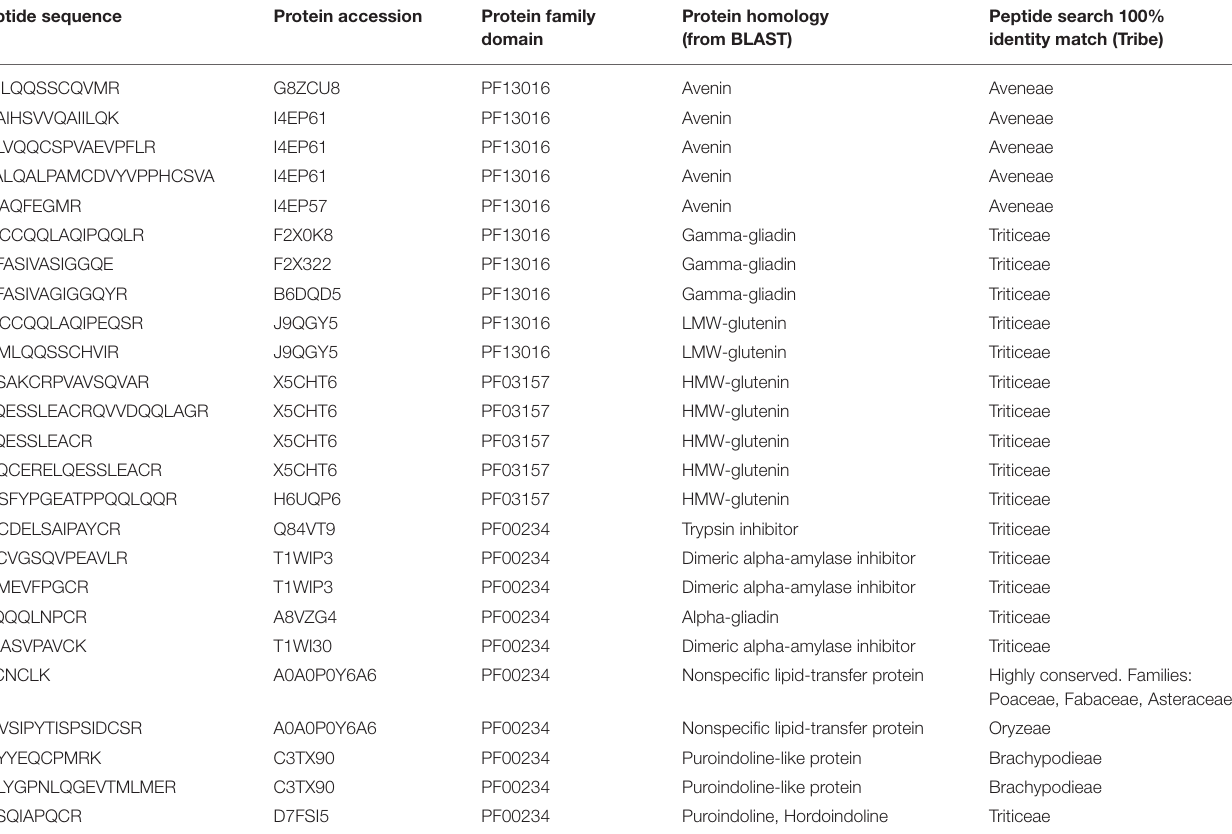
TABLE 1 | Protein and peptide homology search results. Peptide sequence Protein accession Protein family